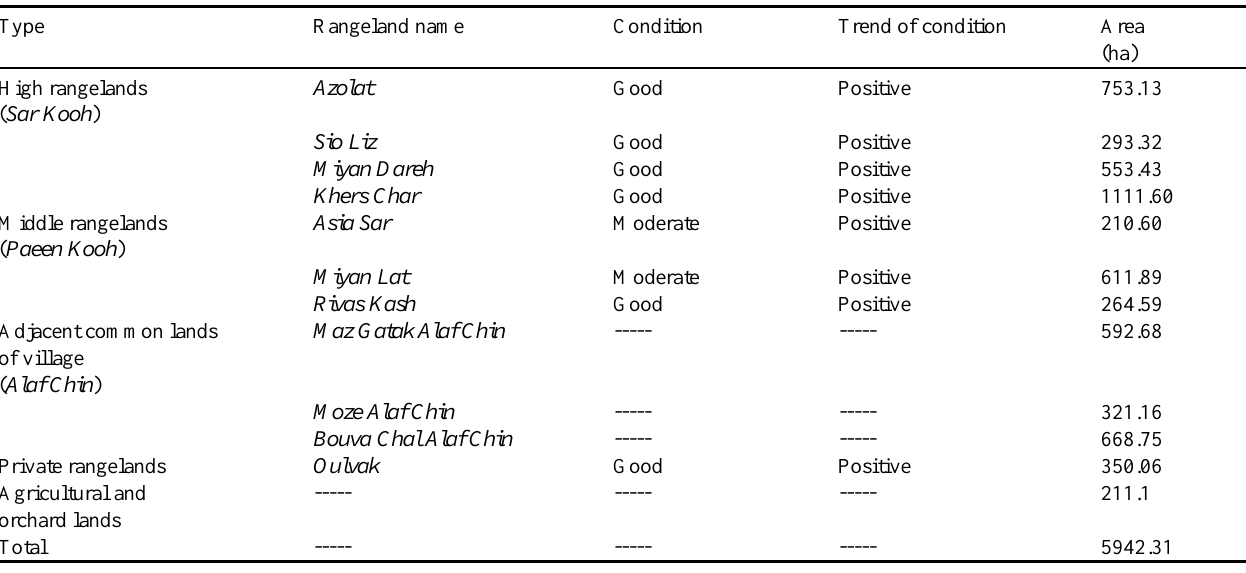
Table 2 . Rangelands in the Saman Orfi of Nariyan village: qualitative classification (District Office of Natural Resources Taleghan